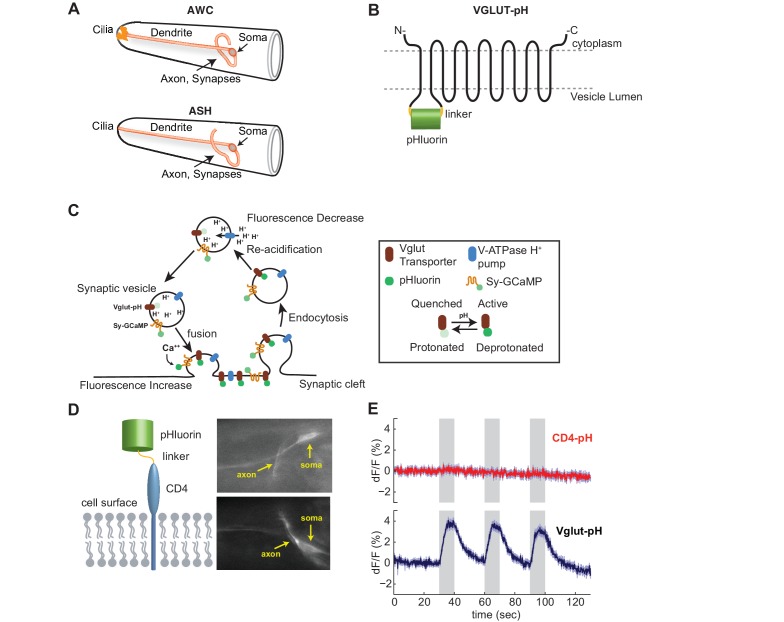
Anatomy of AWCON and ASH and illustration of synaptic reporters.(A) Anatomical diagram of AWC and ASH neurons. Redrawn from www.wormatlas.com. (B) Diagram of VGLUT-pH reporter, with pH-sensitive fluorophore inserted into a lumenal domain of the protein. (C) Diagram of simplified synaptic vesicle cycle, incorporating synaptic activity reporters used here. VGLUT-pH reports pH changes of the synaptic vesicle lumen associated with exocytosis. syGCaMP, a fusion to the synaptic vesicle protein synaptogyrin, reports changes in calcium concentration at the cytosolic face of synaptic vesicles. Although illustrated together, these reagents are used separately. (D) LEFT: Diagram of CD4-pH construct used to target pHluorin to the extracellular surface of ASH. RIGHT: Two animals expressing CD4-pH in ASH under the sra-6 promoter. ASH axon and cell body (soma) indicated. Images are from recordings in (E) and are averages of the first five frames. (E) TOP: Average response of ASH CD4-pH (n = 33 trials, 11 animals, three trials each). No response was detected. BOTTOM: Average response of ASH VGLUT-pH control (n = 39 trials, 13 animals, three trials each). Gray areas mark stimulus periods (500 mM NaCl). Shading = S.E.M.